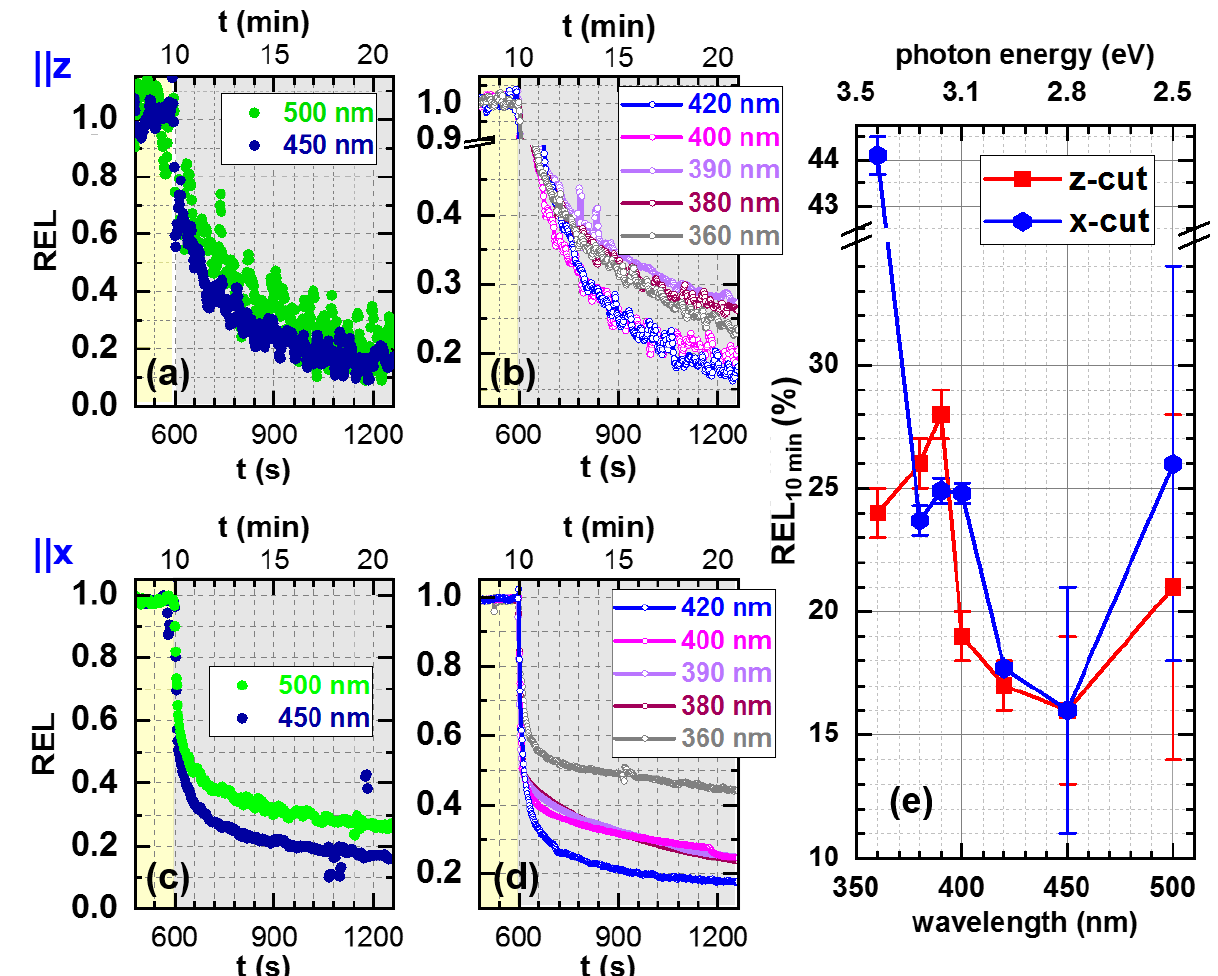
Figure 6. Light-off transients (calculated employing the normalization of Equation (2)) of the ( a , b ) z-cut and ( c , d ) the x-cut SBN61 sample for selected wavelengths, showing the development of the residual excess level of the conductance within the first 10 minutes after the end of a 60-min illumination interval (illustrated in the two previous Figures 4 and 5). Greyish background indicates darkness and yellowish background indicates illumination. Subfigure ( e ) shows the residual excess level after 10 min in the dark, denoted as REL 10 min , plotted against the wavelength and constitutes a kind of a counterpart to Figure